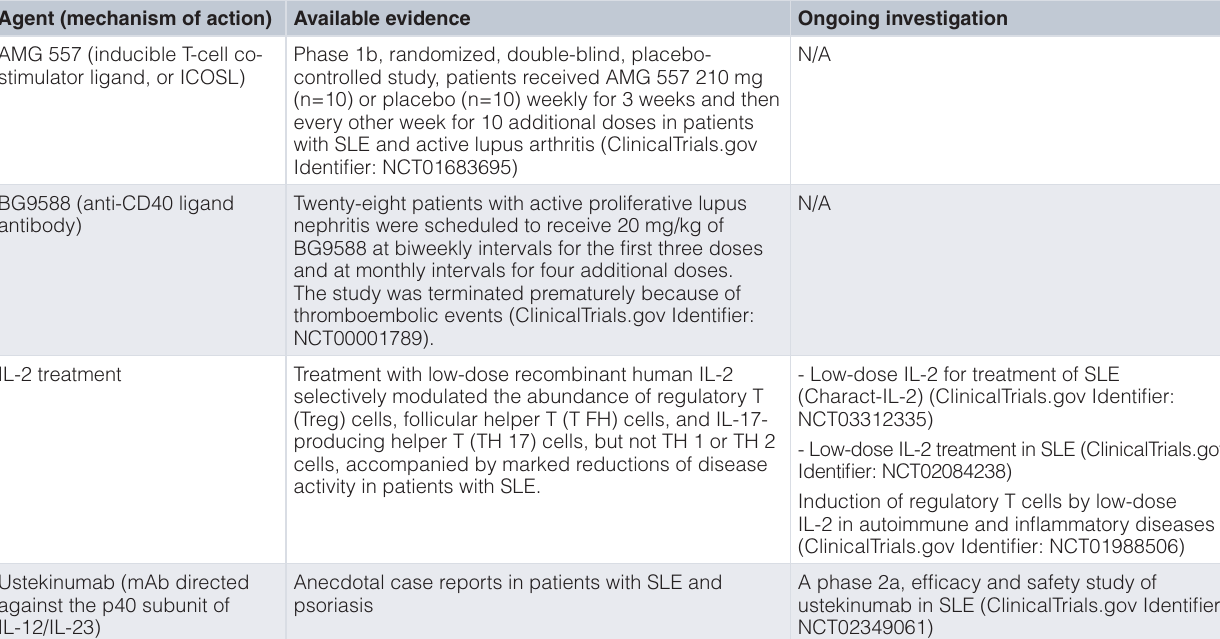
Table 2. Other targeted biologic therapies in systemic lupus erythematosus (SLE). Agent (mechanism of action) Available